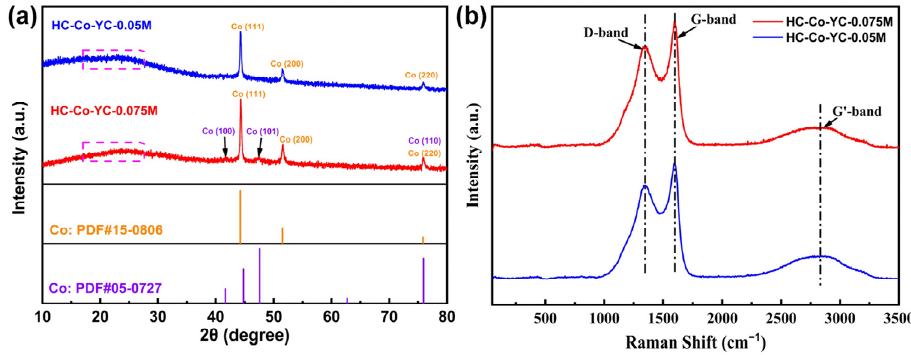
Figure 3. ( a ) XRD patterns and ( b ) Raman spectra of HC–Co–YC–0.05M and HC–Co–YC–0.075M.